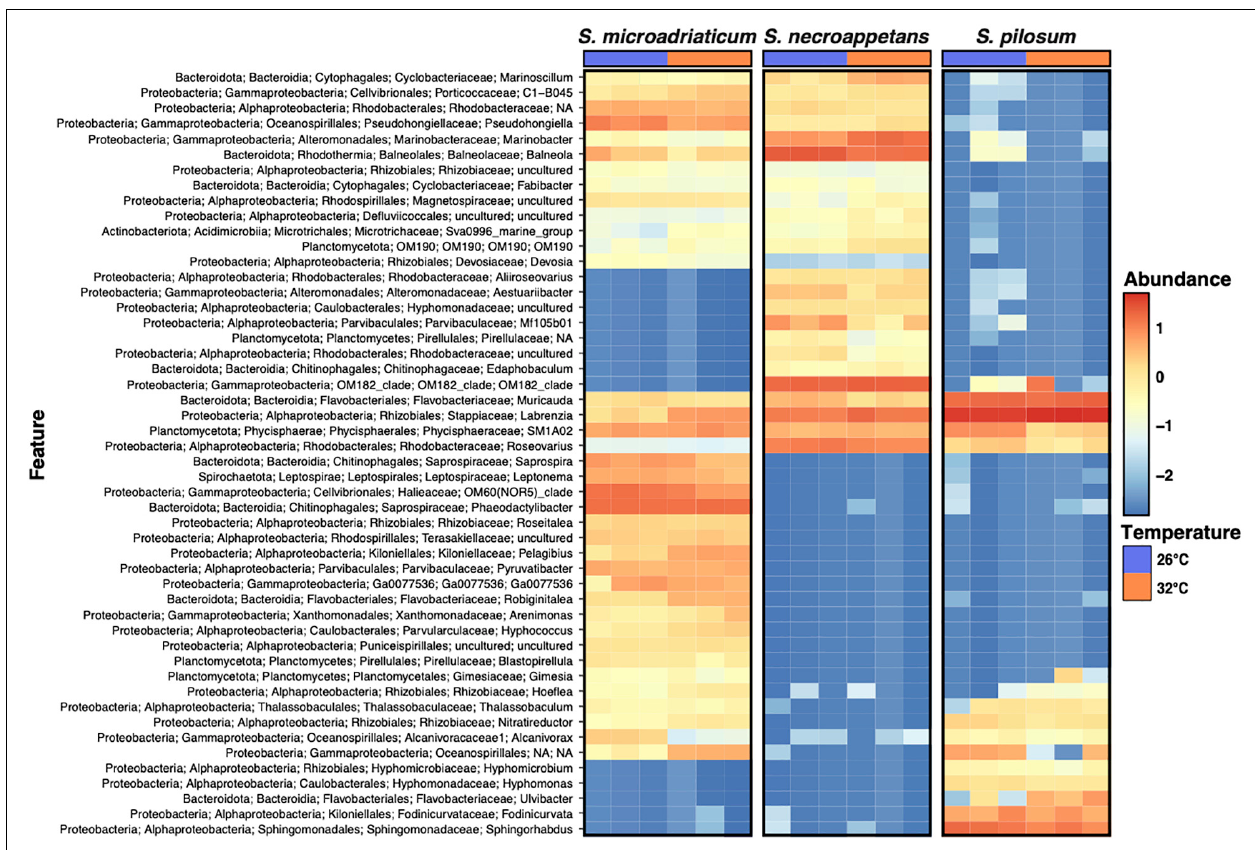
FIGURE 2 | Heatmap of relative abundances calculated in log 10 for the top 50 most abundant